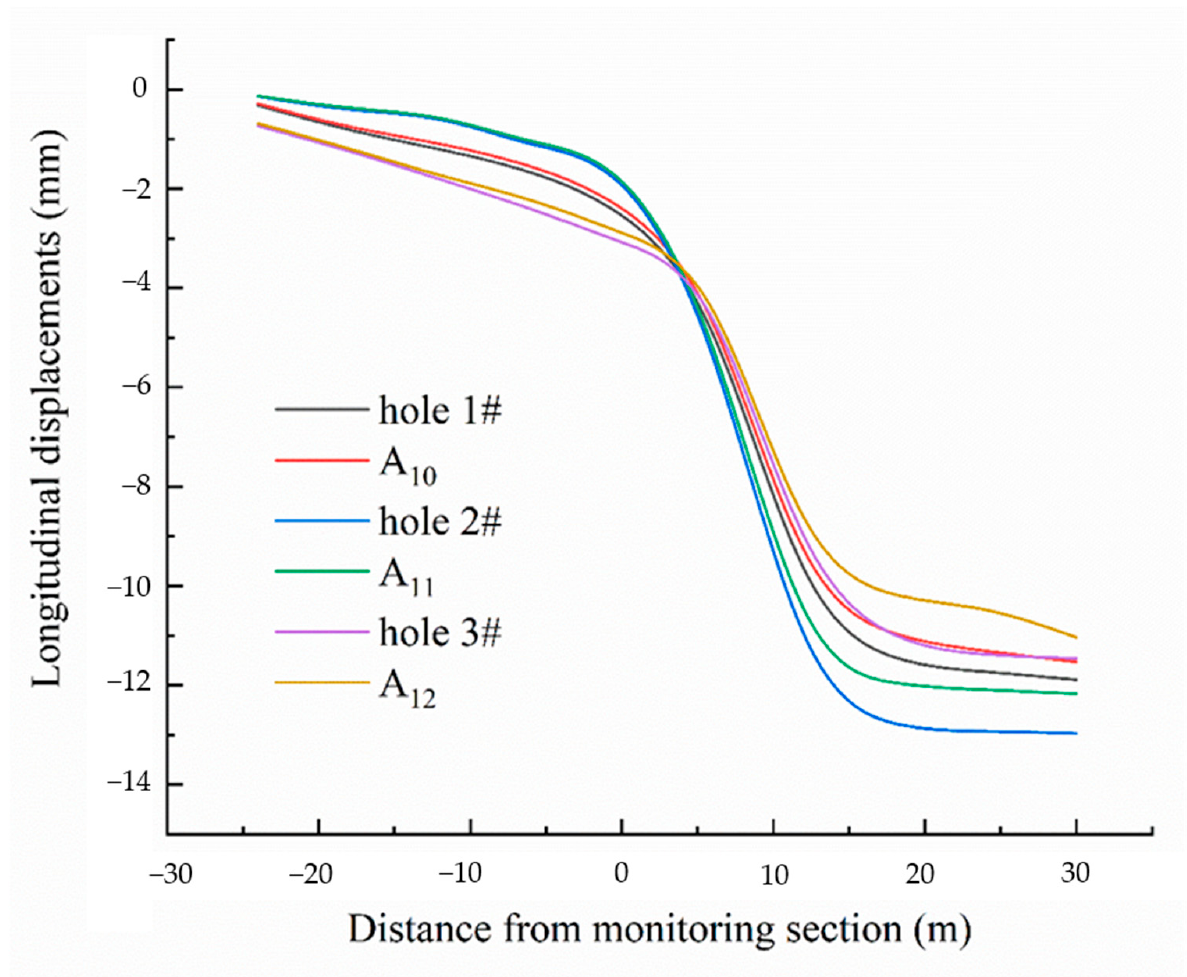
Figure 8. Longitudinal displacement comparison diagram.